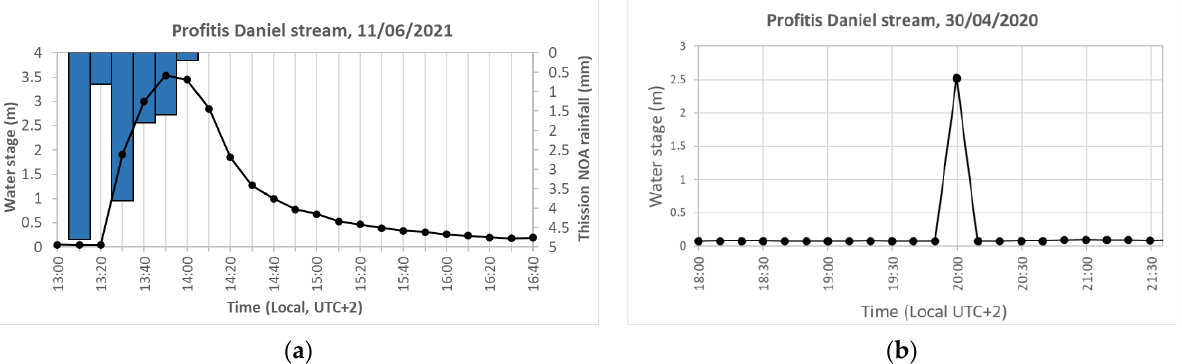
Figure 5. Hydrographs flagged with “warning” in two cases of abrupt water stage changes 10 min time at Prophitis Daniel station exhibiting: ( a ) an actual hydrograph: increase by 1.9 m and ( b ) a spontaneous error in measurement. Blue bars indicate rainfall, lines with dots indicate water stage.